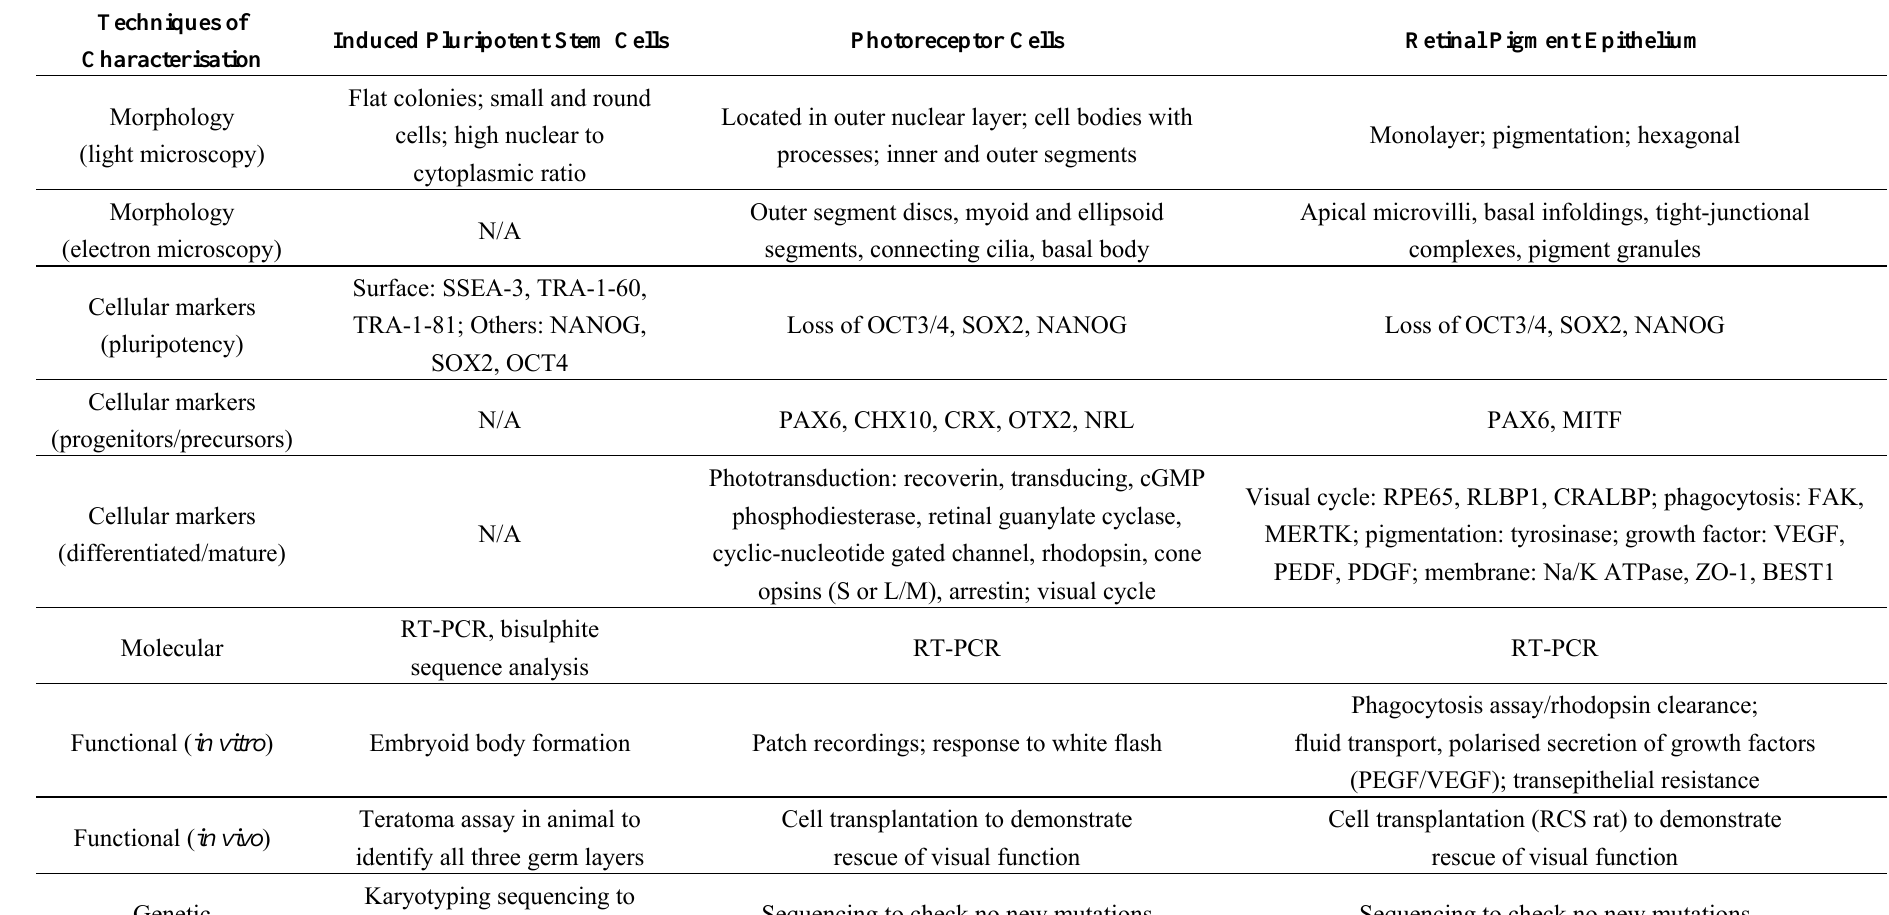
Table 1. Characterisation of induced pluripotent stem cells, photoreceptor cells and retinal pigment